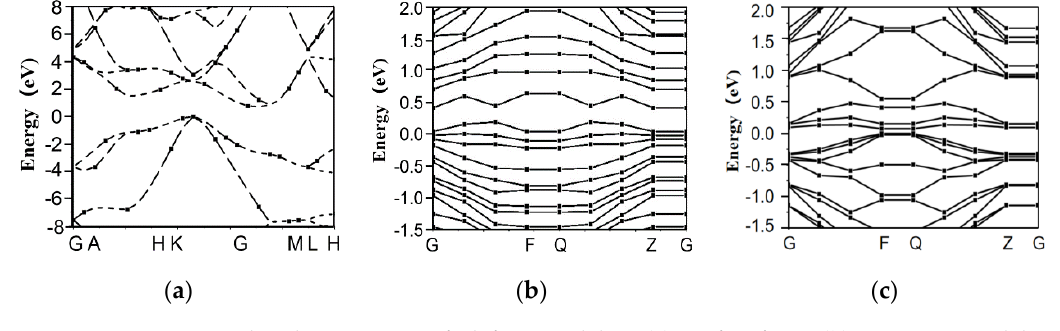
Figure 2. Energy band structures of defect models: ( a ) Defect-free; ( b ) Vacancy model; ( c ) Lattice